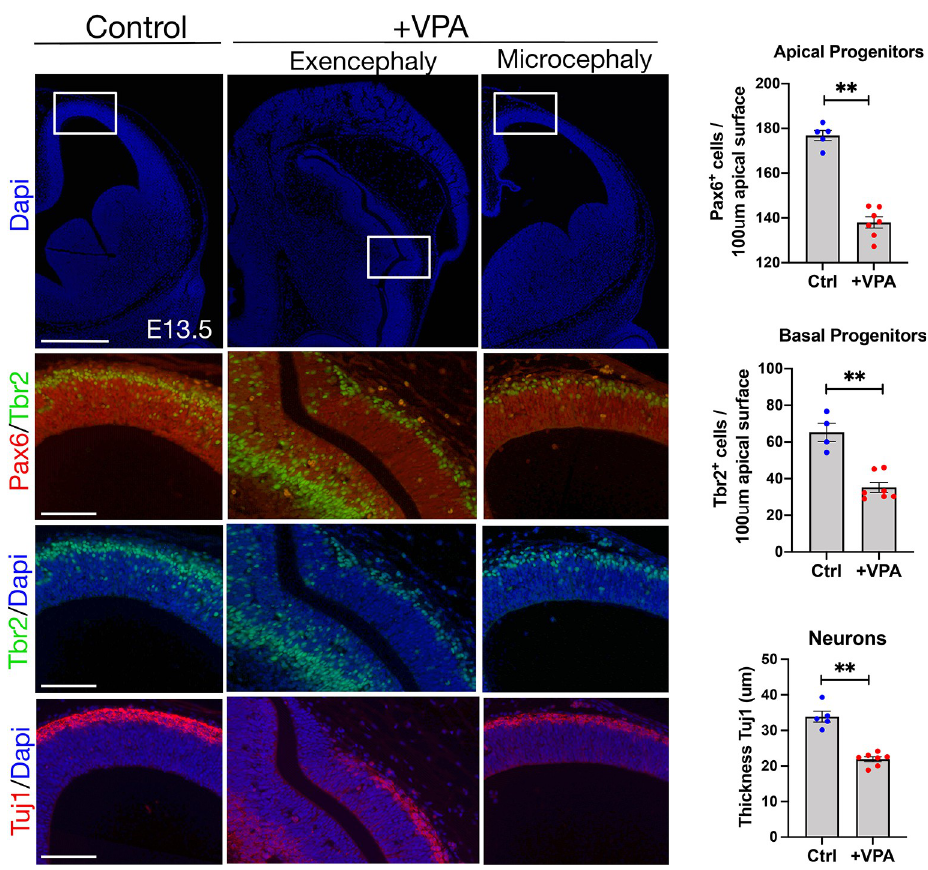
Fig 3. VPA treatment and senescence induction is associated with decreased neurogenesis. Immunostaining for Pax6, Tbr2, and Tuj1 on cortical sections (coronal) of E13.5 embryos. Box highlights the region in lower images. Scale bar, 500 μ m (top row), 100 μ m (rest). Quantification of Pax6 and Tbr2 positive progenitors or the thickness of the neuronal layer in the microcephalic cortical vesicles (for each condition, 5 embryos from at least 4 different mothers were analyzed). Data bars represent mean ± SEM. Mann–Whitney test: �� p � 0.01. The data underlying this figure can be found in S1 Data. E, embryonic day; VPA, valproic